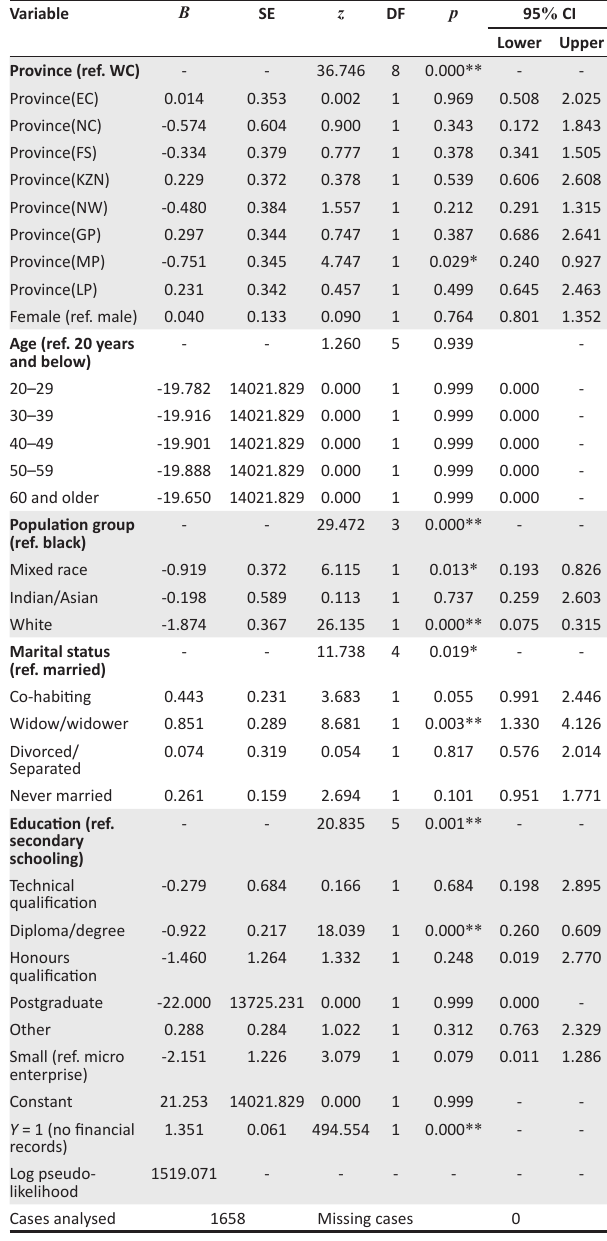
TABLE 1 : Descriptive statistical results emphasising financial record-keeping practices.